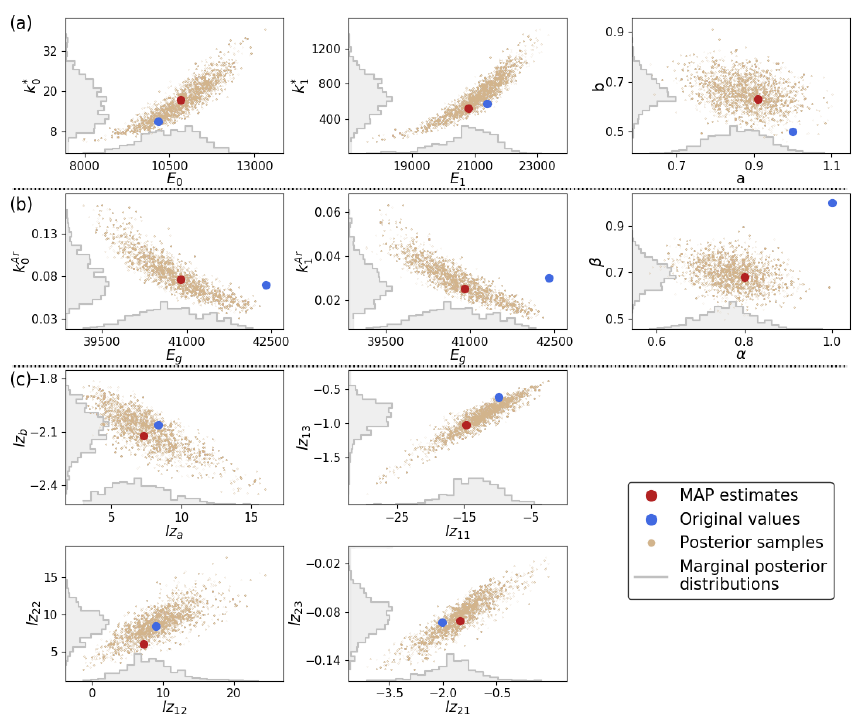
Figure 3. Posterior probability distributions, shown for pairs of parameters, for (a) HL, (b) Ar and (c) LZ. Where possible, correlated parameters share the same graph (see Supplement for full correlation matrices). The posterior samples are 500 randomly selected parameter combinations from the posterior ensembles of each model (HL, Ar, LZ).